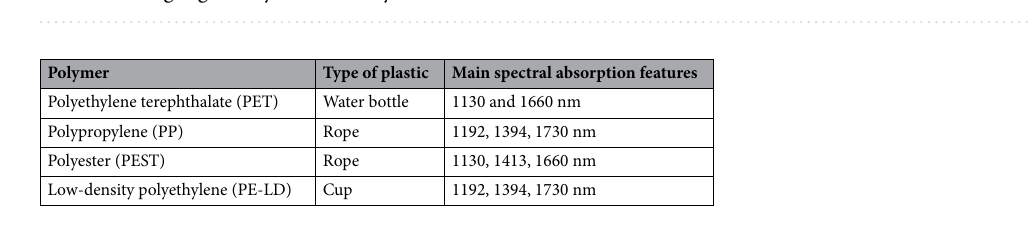
Figure 1. Spectral reflectance of dry virgin ( a ) unrolled Polypropylene (PP) ropes, a Low-density polyethylene (PE-LD) cup ( b ) Polyethylene terephthalate (PET) water bottles and a Polyester (PEST) rope. Absorption features are highlighted by the vertical yellow lines.